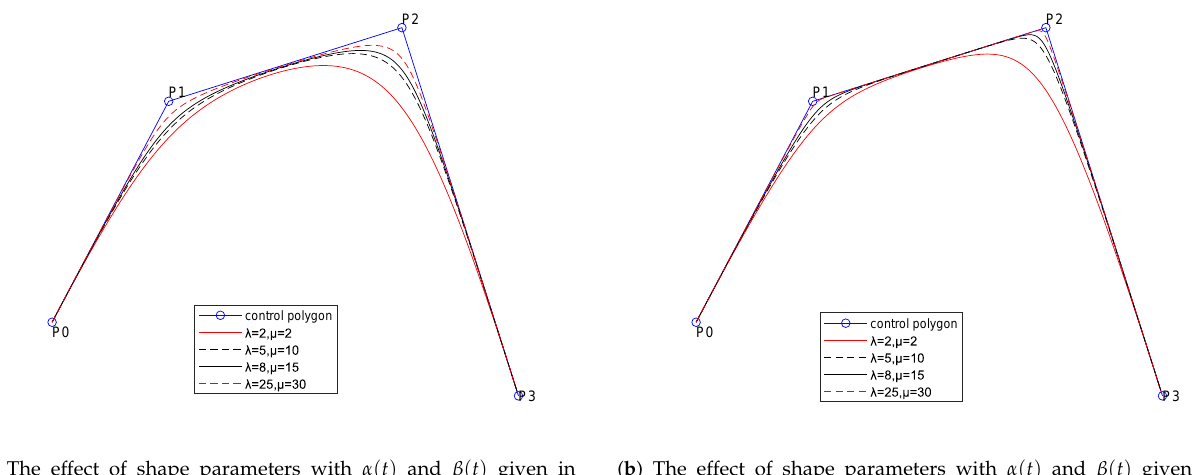
Figure 4. Corner cutting algorithm for computing the quasi trigonometric Bézier curve.